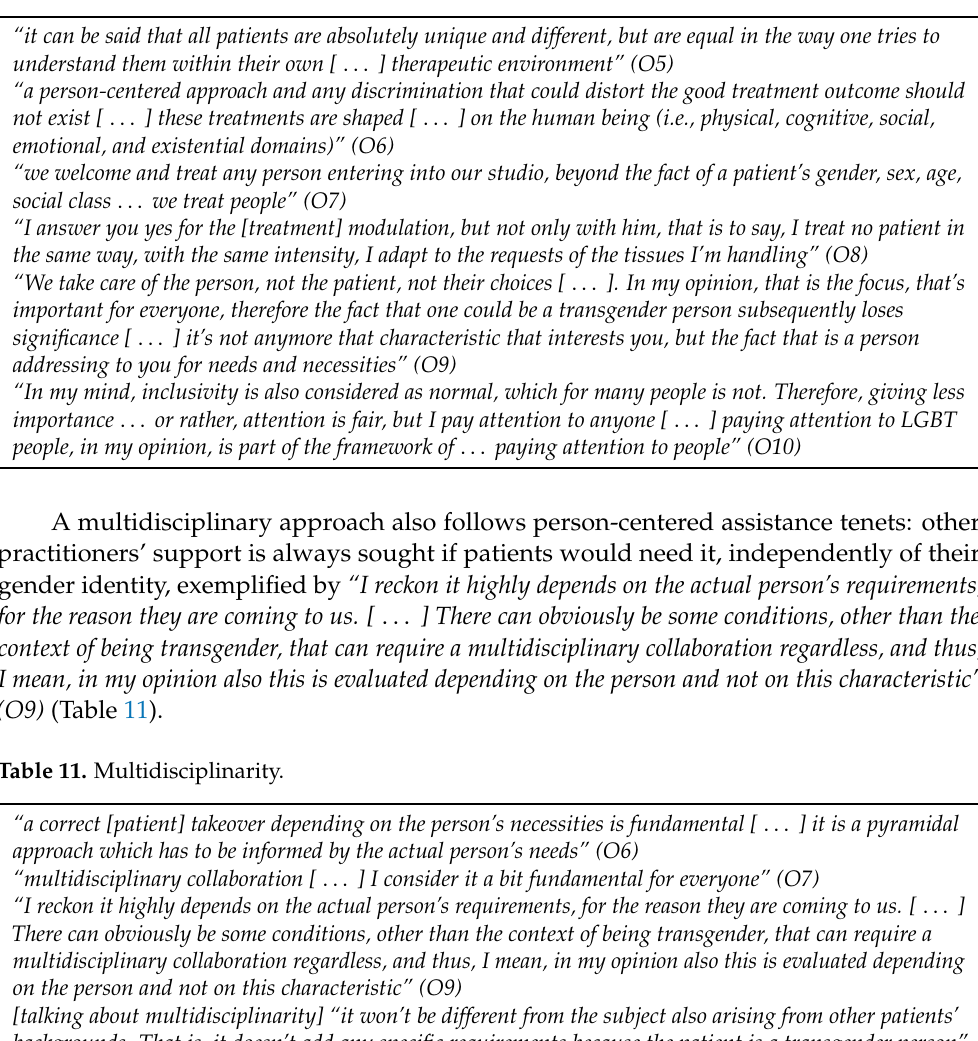
Table 10. No differences in the treatment compared with cisgender people.